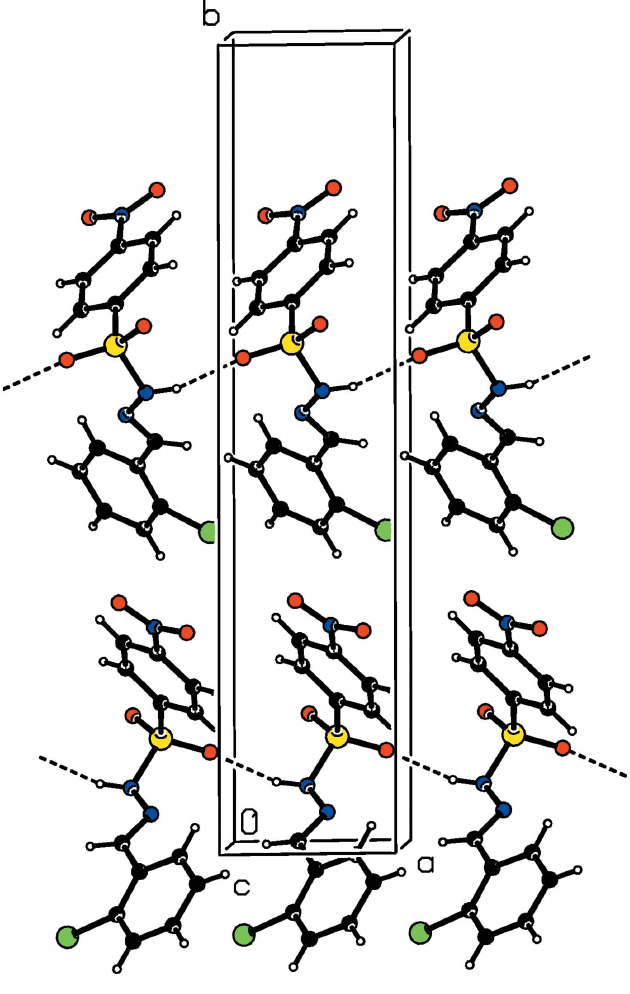
Figure 4 A partial view along the c axis of the crystal packing of compound (I), with hydrogen bonds shown as dashed lines.